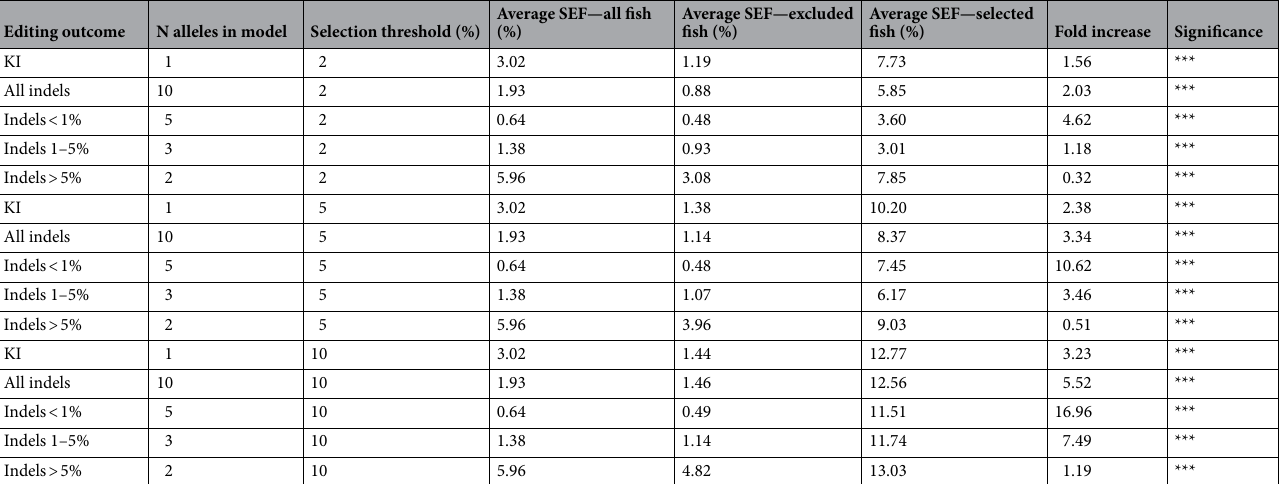
Table 2. Zebrafish embryo genotyper-based embryo selection at the BrS locus (n = 43 fish for KI and n = 43 fish for indels). KI knock-in, indel insertion/deletion, SEF somatic editing frequency, N number, NS not calculated as (Average SEF selected fish – average SEF all fish)/average SEF all